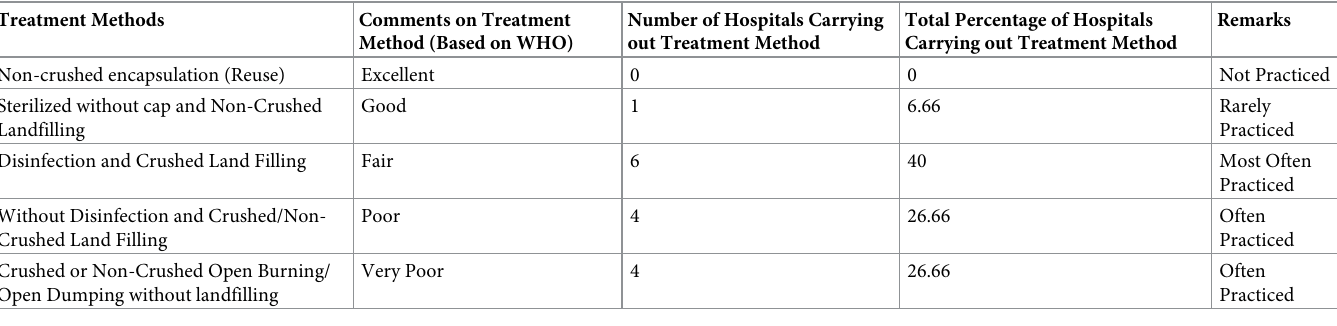
Table 5. Treatment methods for vials disposal in the studied health complex.